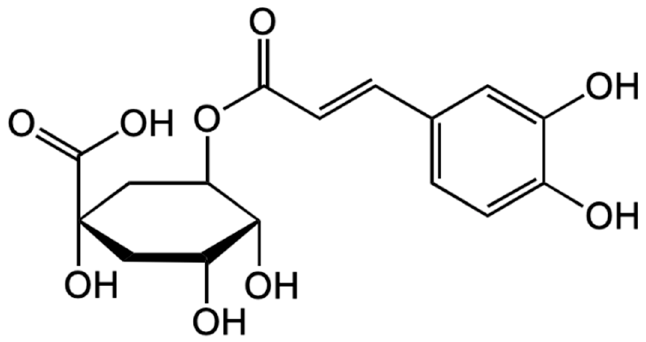
Figure 2. Chemical structure of chlorogenic acid (5-O-caffeoylquinic acid). Onakpoya et al. and Zhao et al. have proved that chlorogenic acid shows antihyper- tensive properties [62,63].